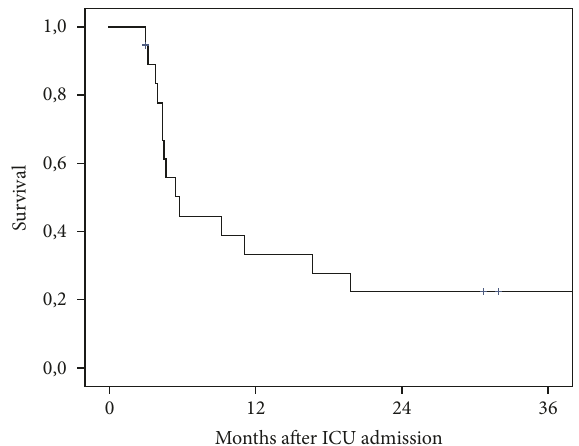
Figure 1: Survival of surgical patient with ICU LOS of 90 days and greater.